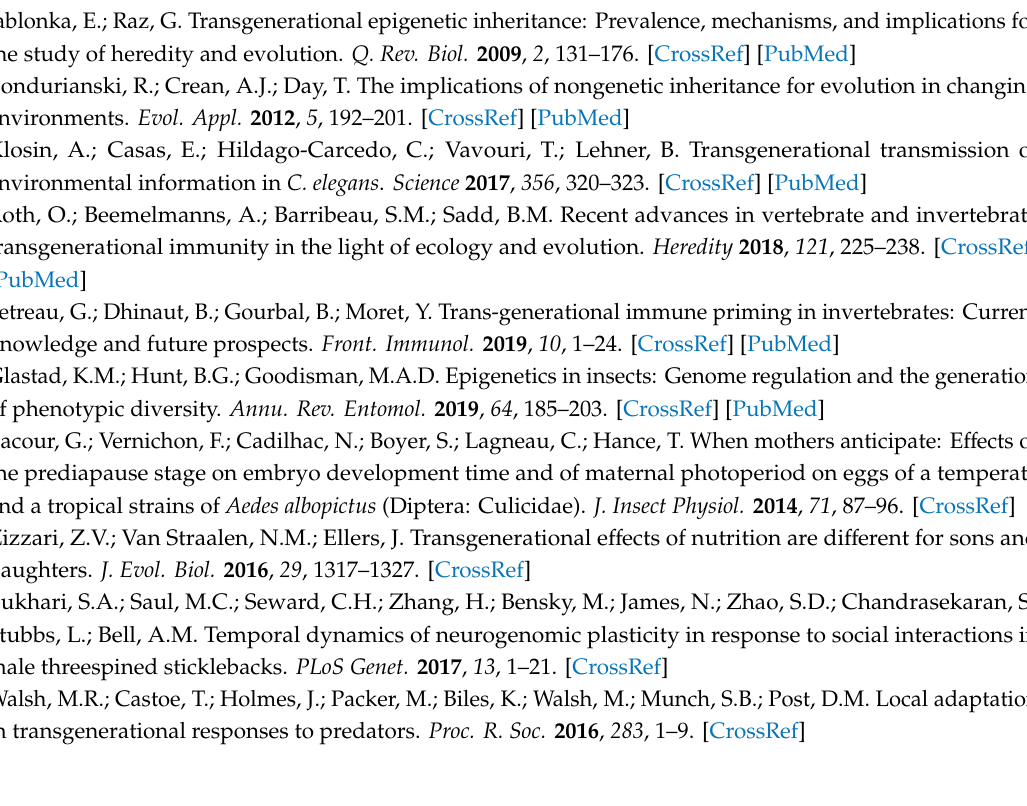
Table S3: Maternal e ff ects: T -tests of raw growth rates. Table S4: E ff ects of parental treatment on embryonic antimicrobial activity (General linear mixed e ff ects model). Table S5: Descriptive statistics and tests of normalcy (Shapiro-Wilk) of total protein (mg /